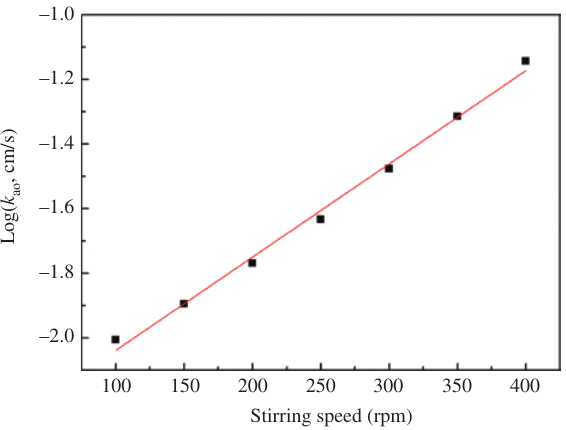
Figure 2: Effect of stirring speed on mass transfer